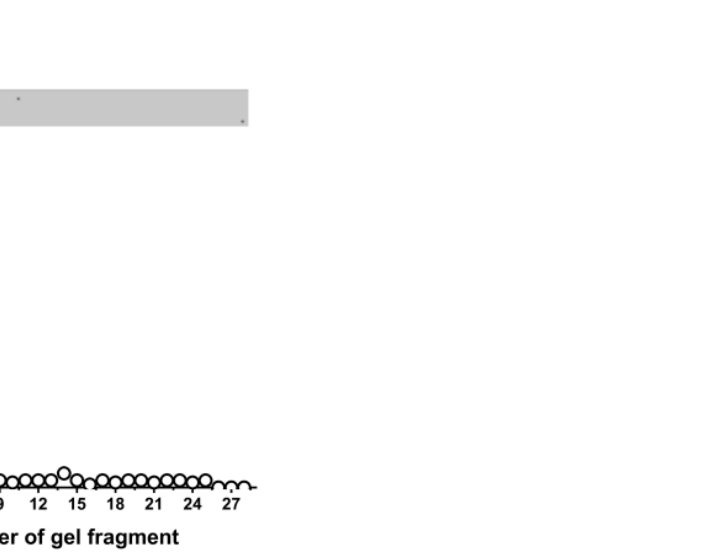
Figure 2. SDS-PAGE analysis of the electrophoretic homogeneity of IgG mix corresponding to a mixture of 21 individual IgG preparations (19 μ g) in 4 – 18% gradient gel followed by silver staining ( A ). After SDS-PAGE, the gel was incubated using the special solution to remove the SDS and for IgG renaturation. The relative catalase activity was estimated using 15 µL extracts of 2.6 – 3.1-mm fragments of one longitudinal gel slice ( B ). The errors from 2 independent experiments in the initial rate determination process did not exceed 8 – 10%.